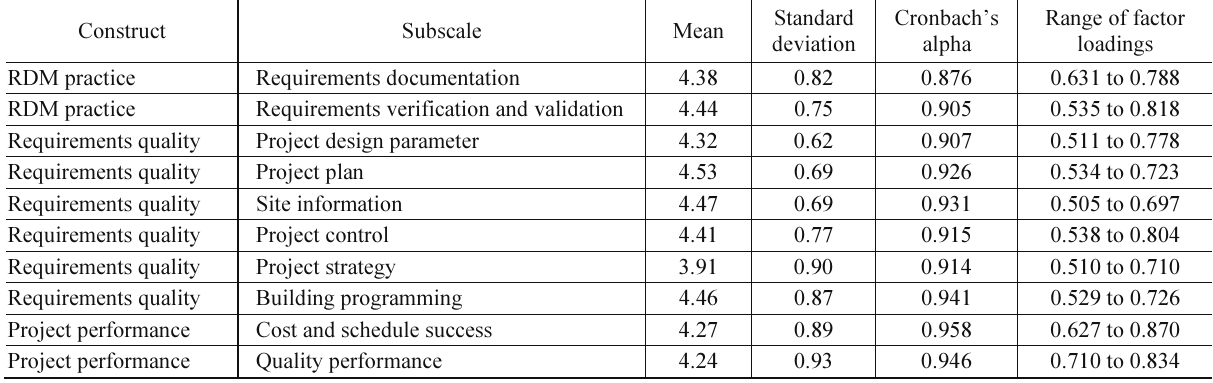
Table 1. Factor loadings and Cronbach's alpha values for the survey items